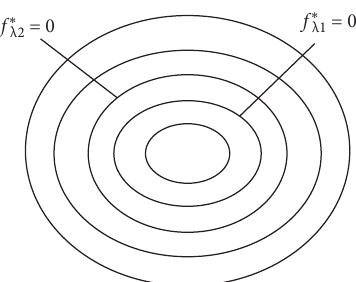
Figure 1: Fuzzy plastic yield surface.